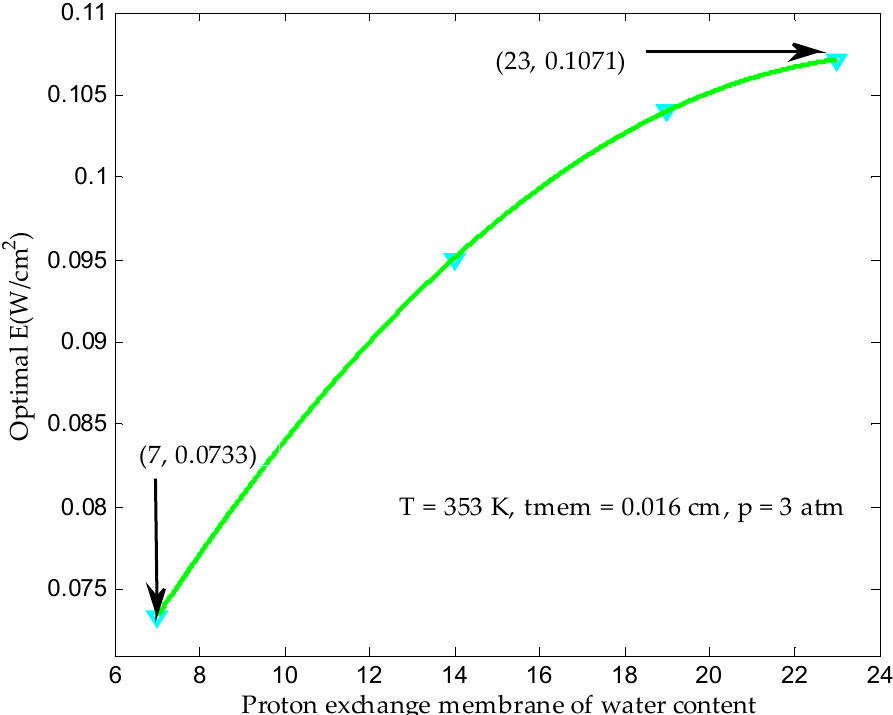
Figure 14. Optimal ecological objective function varying with membrane water content.